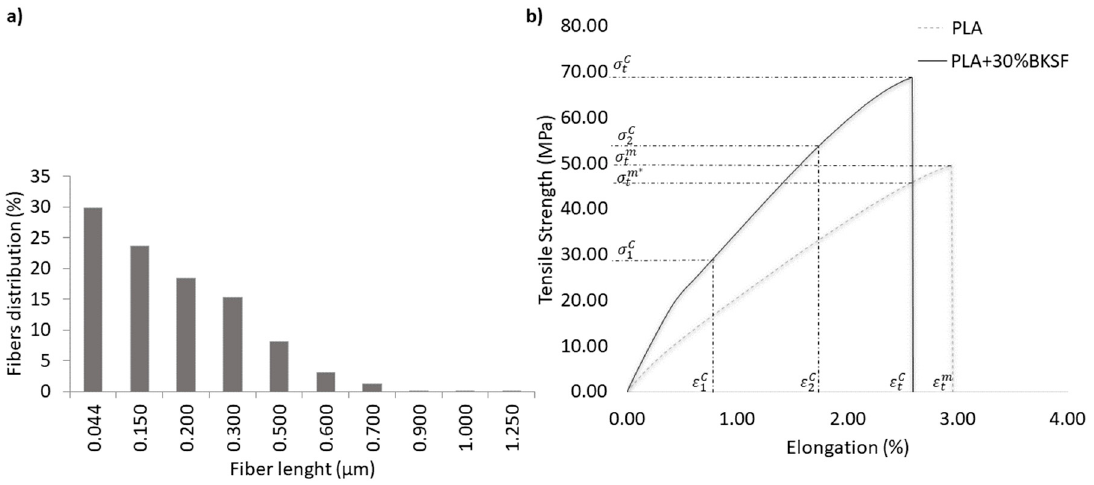
Figure 6. ( a ) Fiber lengths distribution of PLA + 30BKSF. ( b ) Elongation-tensile strength curves of the PLA matrix and the composite reinforced with 30% BKSF.